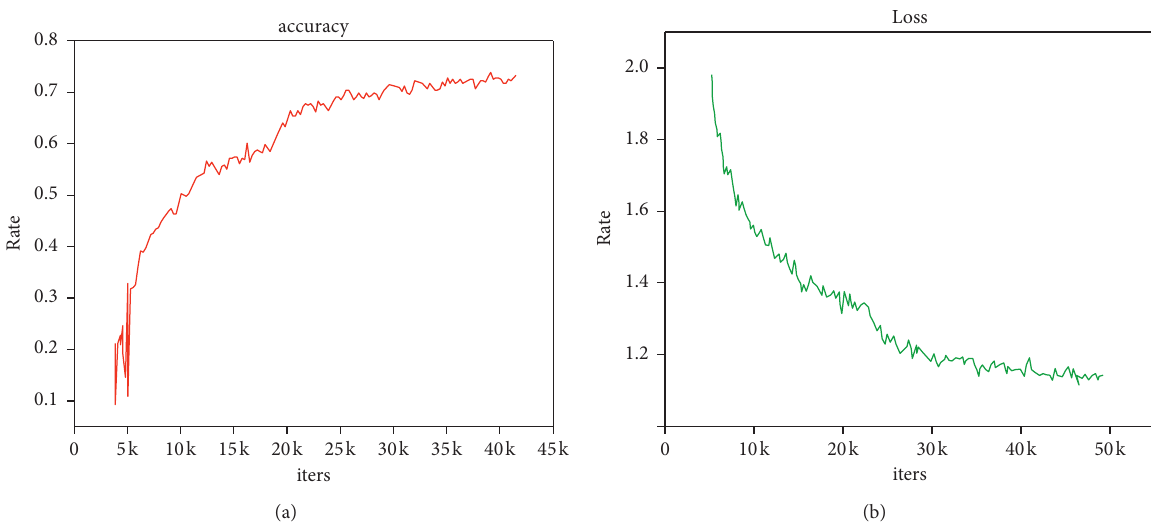
Figure 15: Accuracy curve (a) loss function (b) for training with CNN neural